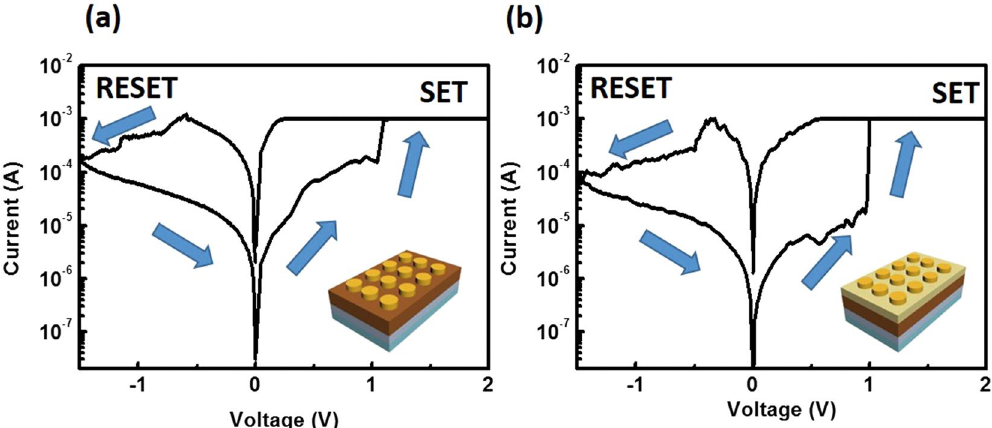
Figure 2. Resistive switching characteristics of hybrid OIP based devices. ( a ) Au/CH 3 NH 3 PbI 3 /ITO/glass devices and ( b ) Au/ZnO/CH 3 NH 3 PbI 3 /ITO/glass